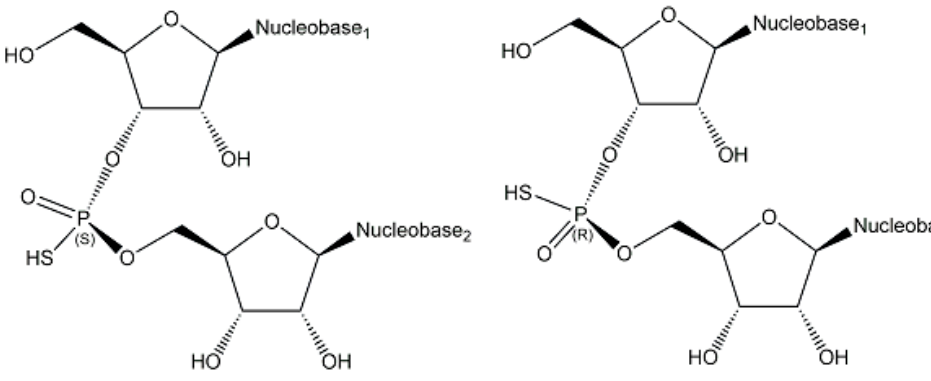
Figure 10. Selected phosphorothioate-linked dinucleotides.